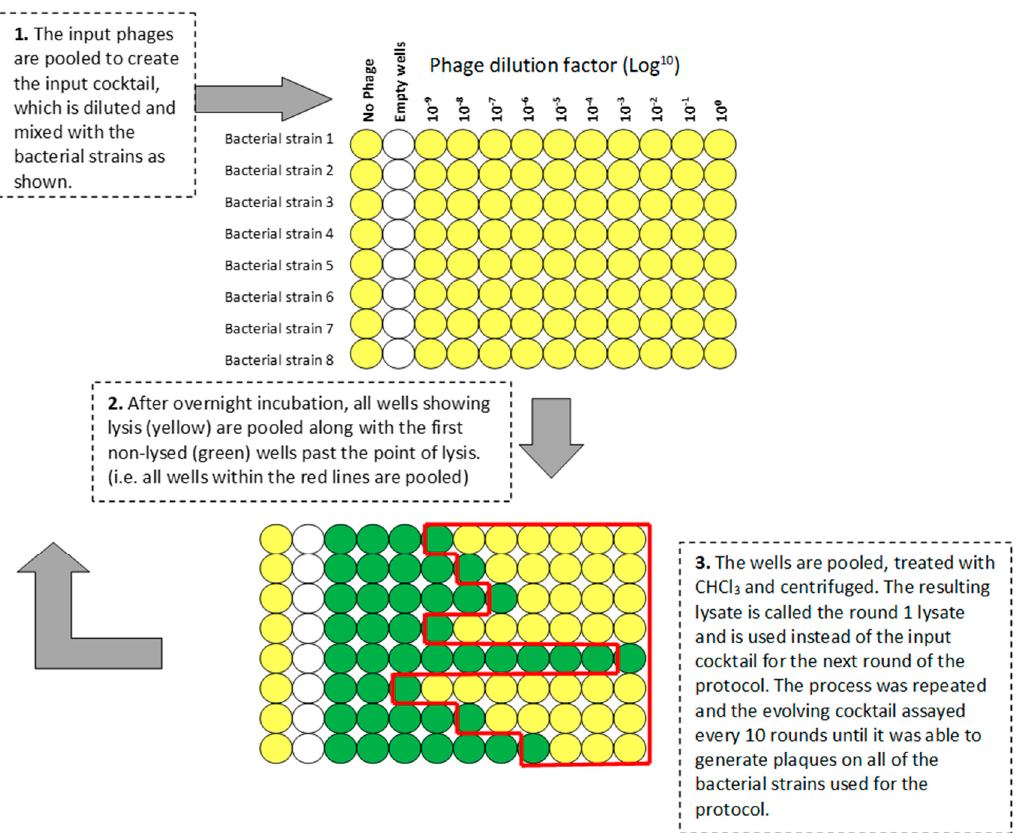
Figure 1. Schematic representation of the 96-well-plate-format Appelmans protocol. Table 2. Phage host range. A 10 µ L spot of a lysate containing ≥ 10 6 plaque-forming units (pfu)